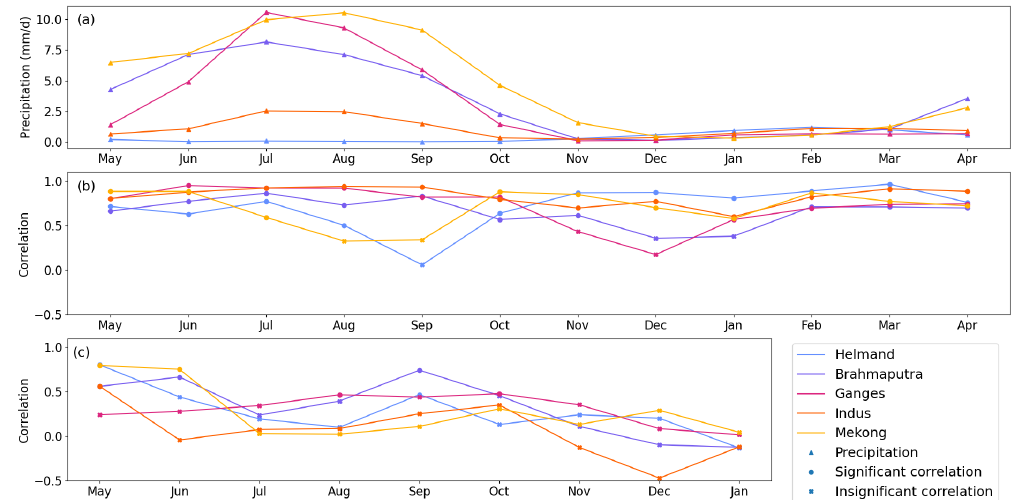
Figure 10. Comparison of (a) monthly retrospective precipitation climatology, (b) inter-annual correlation between monthly ESA-CCI SM product and monthly retrospective surface soil moisture (top 10cm) and (c) inter-annual correlation between monthly ESA-CCI SM product and monthly forecasting SSM in five major river basins in South and Southeast Asia. Please note that the SSM data for a basin in a year are flagged as missing data if more than 50% of data points in a basin are missing in ESA-CCI SM monthly data. The criterion of significance of correlation are then different due to different sample